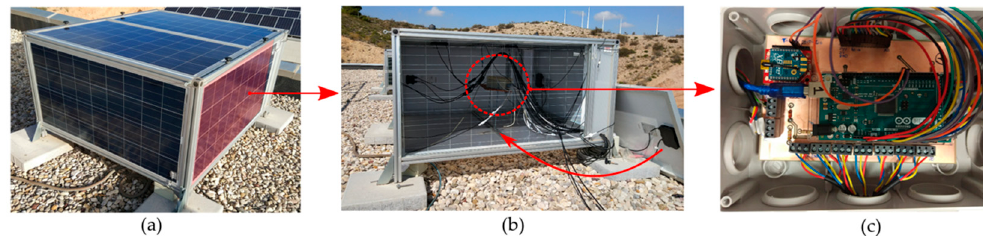
Figure 1. ( a ) c-Si PVCube installed on the rooftop of one of the buildings at the University of Murcia. Orientation of each face is south, north, west, east and horizontal (top). ( b ) Inside of the c-Si PV-cube: Temperature sensors are attached to the back and frontside of each photovoltaic (PV) module. Additionally, in the centre, temperature and humidity sensors are installed. ( c ) Data logger system: Arduino and Xbee transmitter, both installed inside of the PVCube.